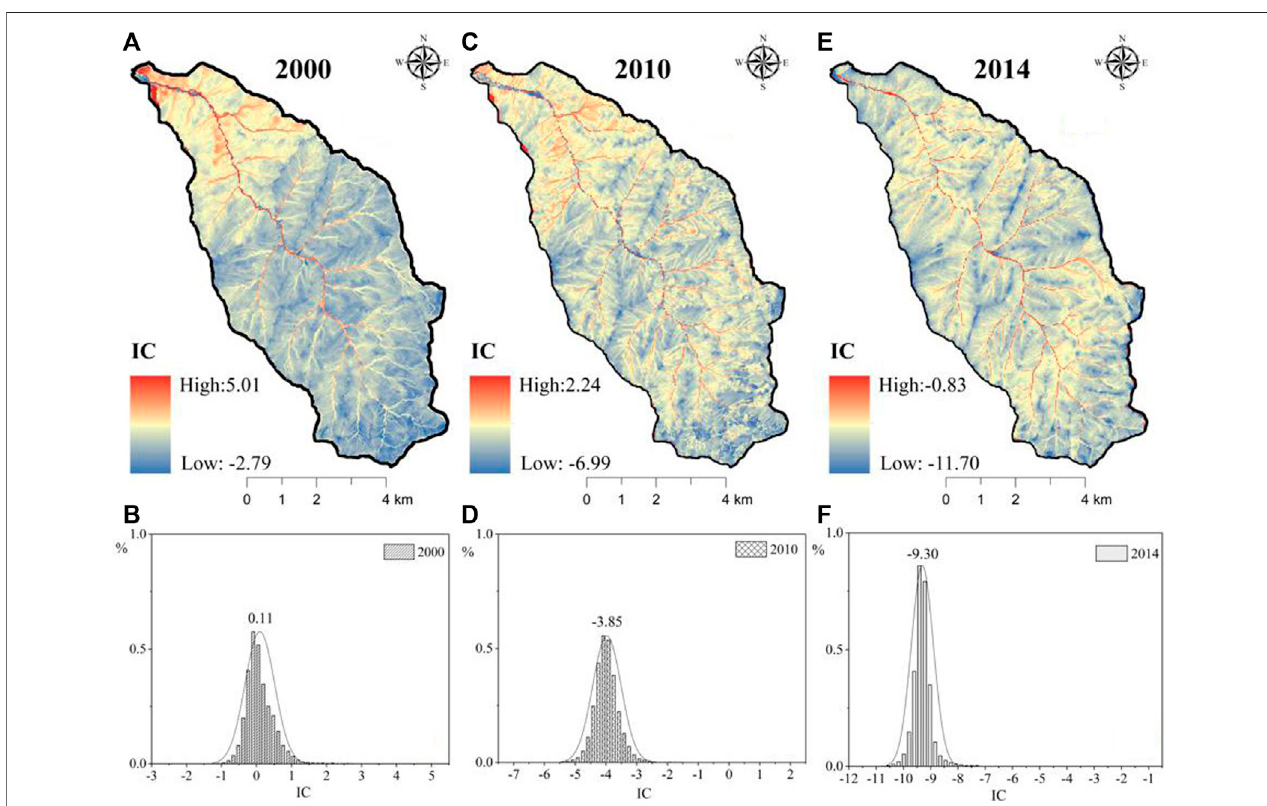
FIGURE 9 | Distribution of the IC values. (A) Sediment connectivity in 2000, prior to the 2008 earthquake. (C) Sediment connectivity in 2010. (E) Sediment connectivity in 2014 (B,D,F) IC values with Gaussian distributions. The expectation values are used to describe the variation in the IC values.